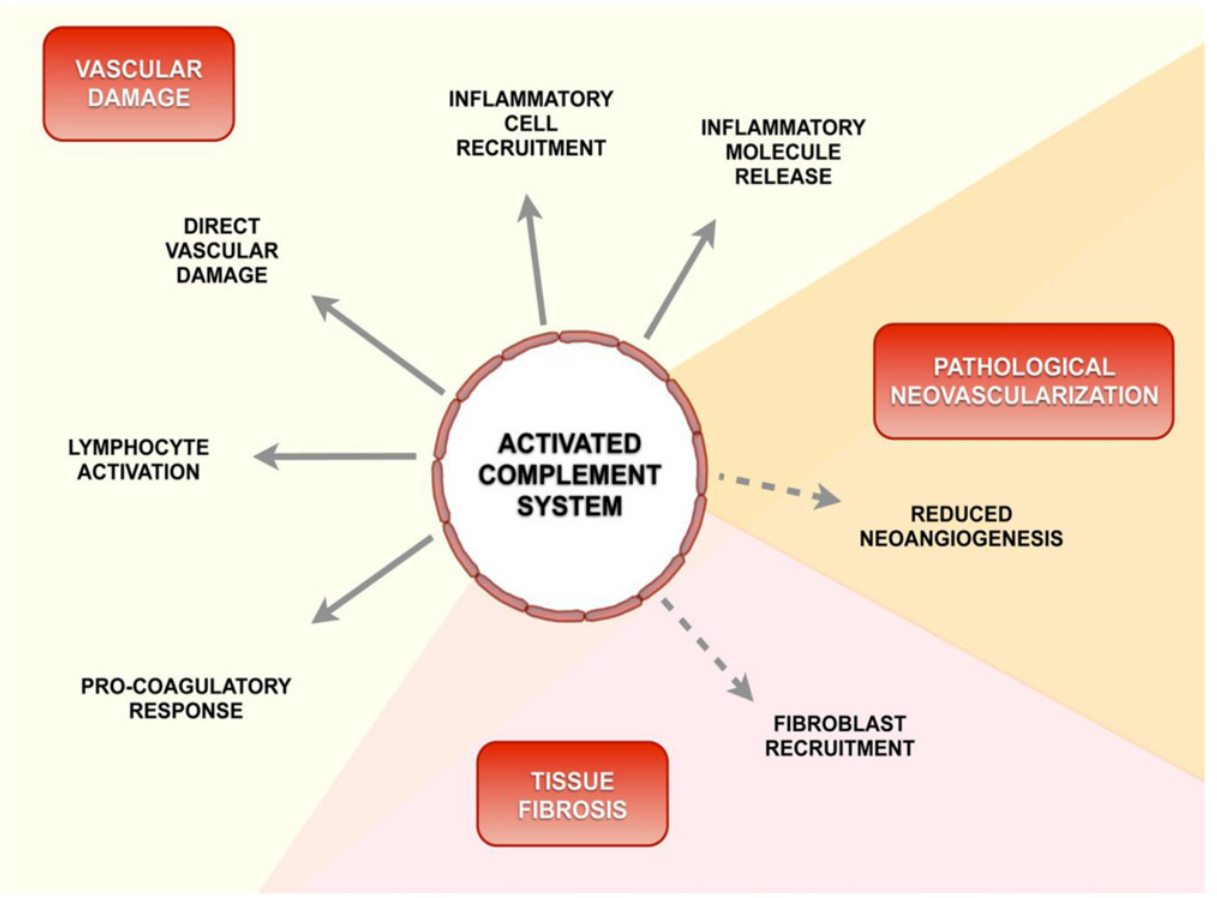
Fig 5. Schematic diagram of a possible role of activated complement in the pathogenesis of SSc. Beside its conventional role in the innate immunity, recent evidence suggests that complement system modulates the acquired immunity and regulates the coagulation cascade activation. Locally, activated complement products reduce neoangiogenesis and promote tissue